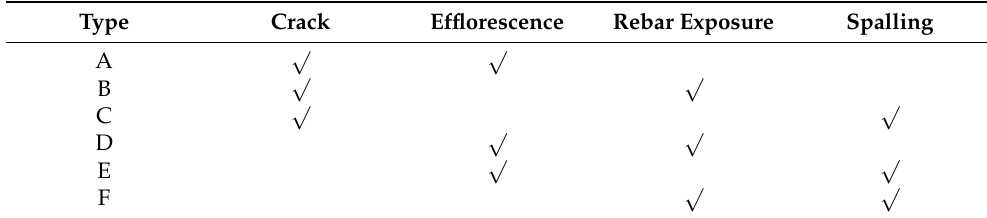
Table 3. Combinations of six types of RC damage images.